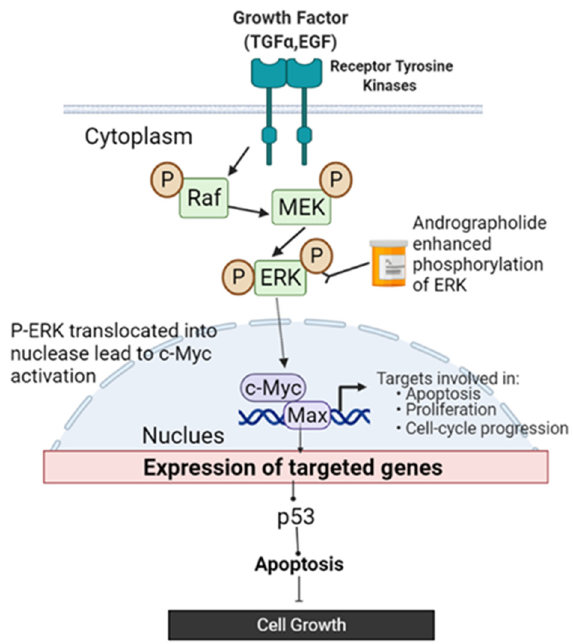
Figure 7. Schematic presentation of the proposed mechanism of the anticancer effect of andro- grapholide on DBTRG-05MG cells. The ERK/c-Myc/p53 signaling pathway was involved in andro- grapholide-induced